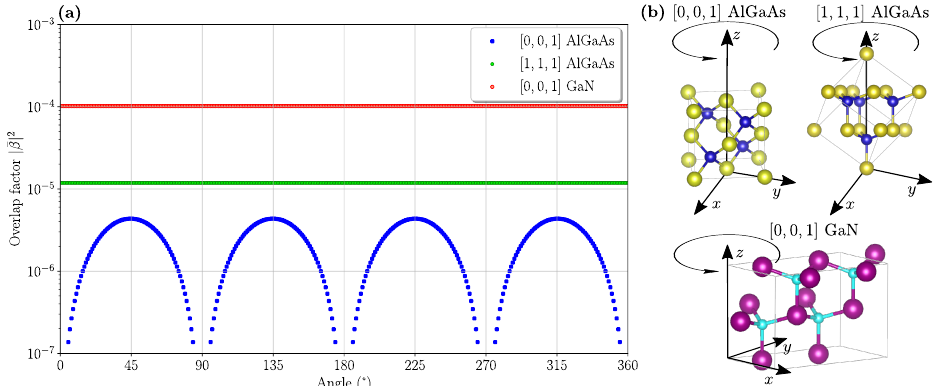
Figure 6. ( a ) Nonlinear overlap factor between FH and SH modes in the doubly-resonant PhC ¯ β 2 , for GaN and Al cavity design, 0.3 Ga 0.7 As grown along different directions, as a function of the | | rotation angle in the PhC lattice plane where 0° indicates the [1,0,0] direction. A schematic of the unit cells and the definition of the rotation angles for the three cases considered is reported in ( b ); these crystallographic pictures were obtained through the VESTA software